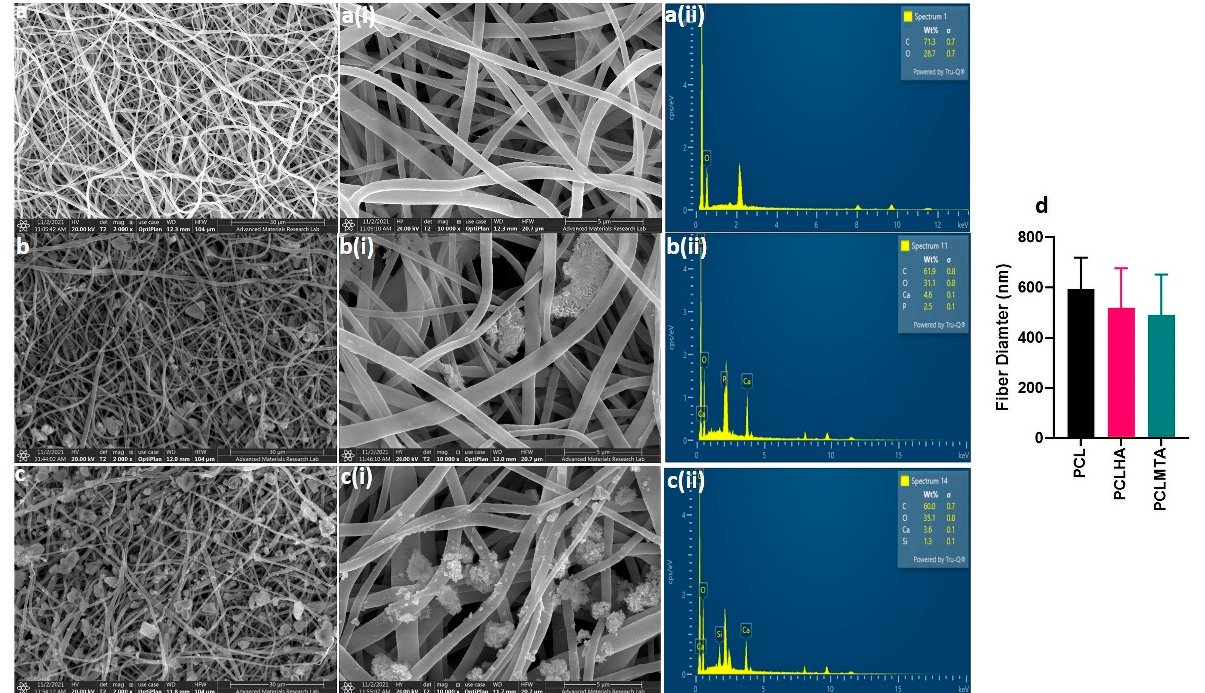
Figure 2. Representative FE ‐ SEM and the corresponding EDX images of the electrospun PCL membranes. FE ‐ SEM images of each electrospun membrane at different magnifications are provided for PCL ( a , a ( i )), PCLHA ( b , b ( i )), and PCLMTA ( c , c ( i )) and the corresponding EDX images for PCL ( a ( ii )), PCLHA ( b ( ii )), and PCLMTA ( c ( ii )). The fiber diameter for each membrane obtained by image J analysis is represented in a bar chart with mean ± standard deviation in ( d ).